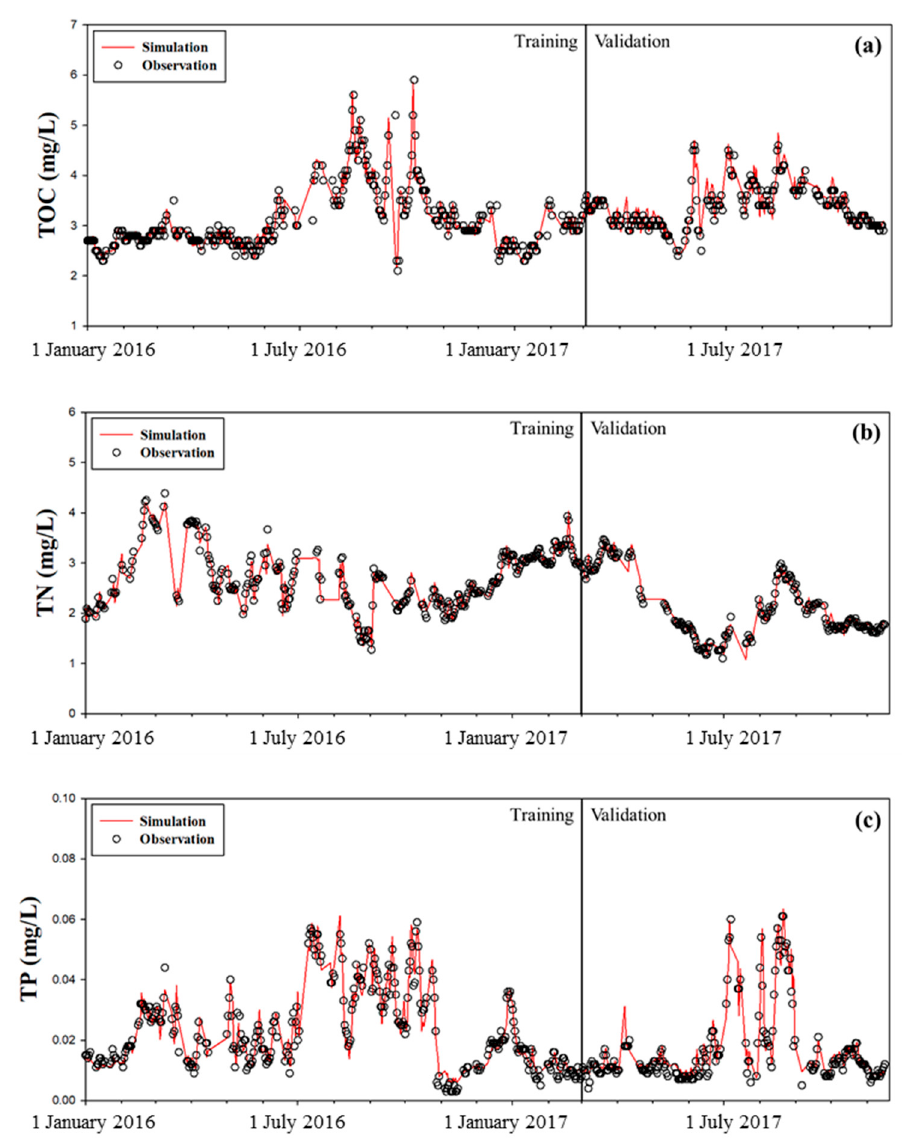
Figure 5. Comparison of the observed and simulated pollutants: ( a ) TOC, ( b ) TN and ( c )